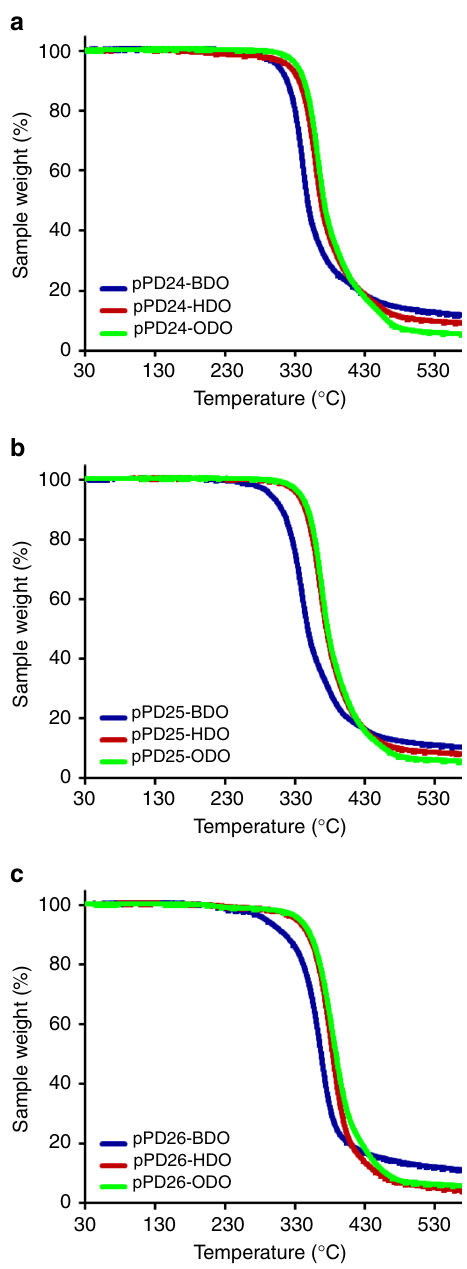
Fig. 5 Thermogravimetric analysis of the polymers. a PD24, b PD25, and c PD26 in combination with 1,4-butanediol (C 4 , blue line), 1,6-hexanediol (C 6 , red line), and 1,8-octanediol (C 8 , green line) in the DPE reaction system using immobilized CaLB as the biocatalyst. Runs were conducted using N 2 as the inert